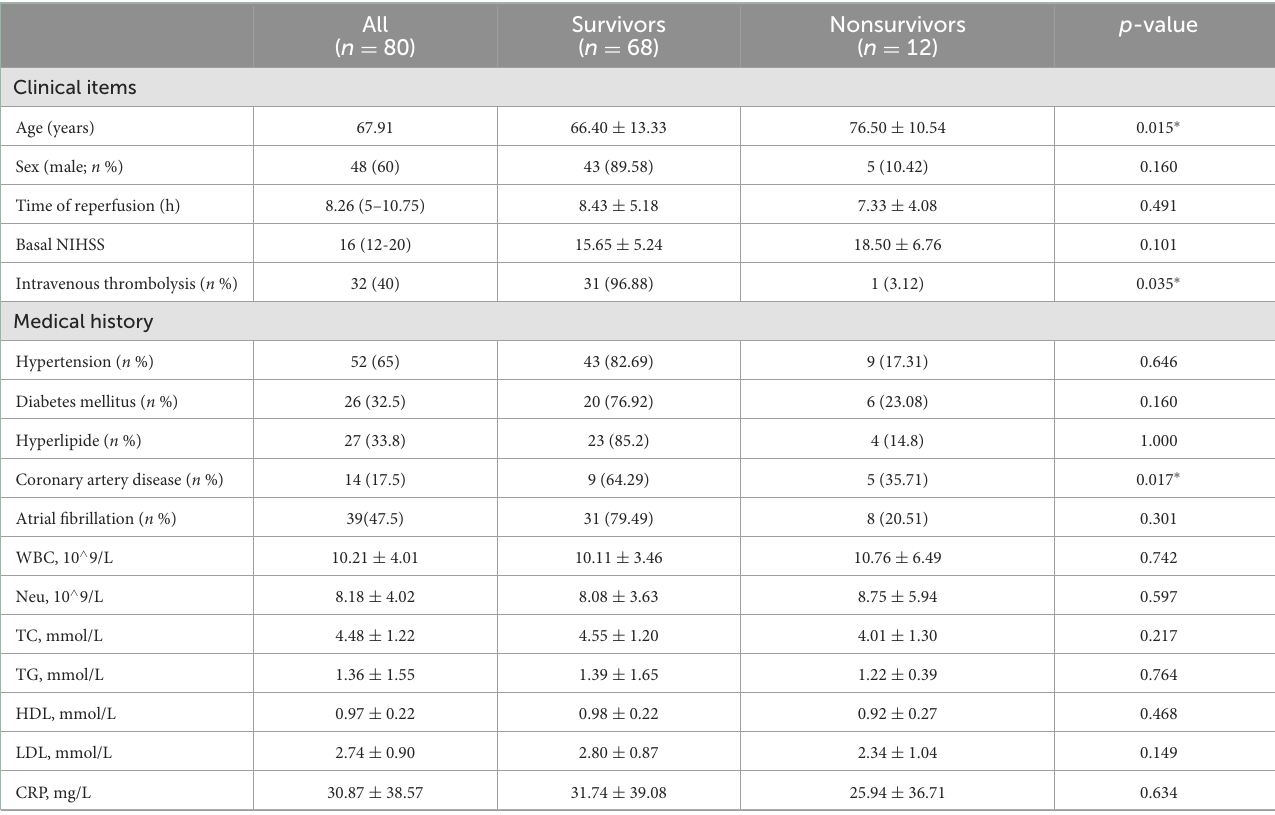
TABLE 1 Clinical Baseline Characteristics in survivors and